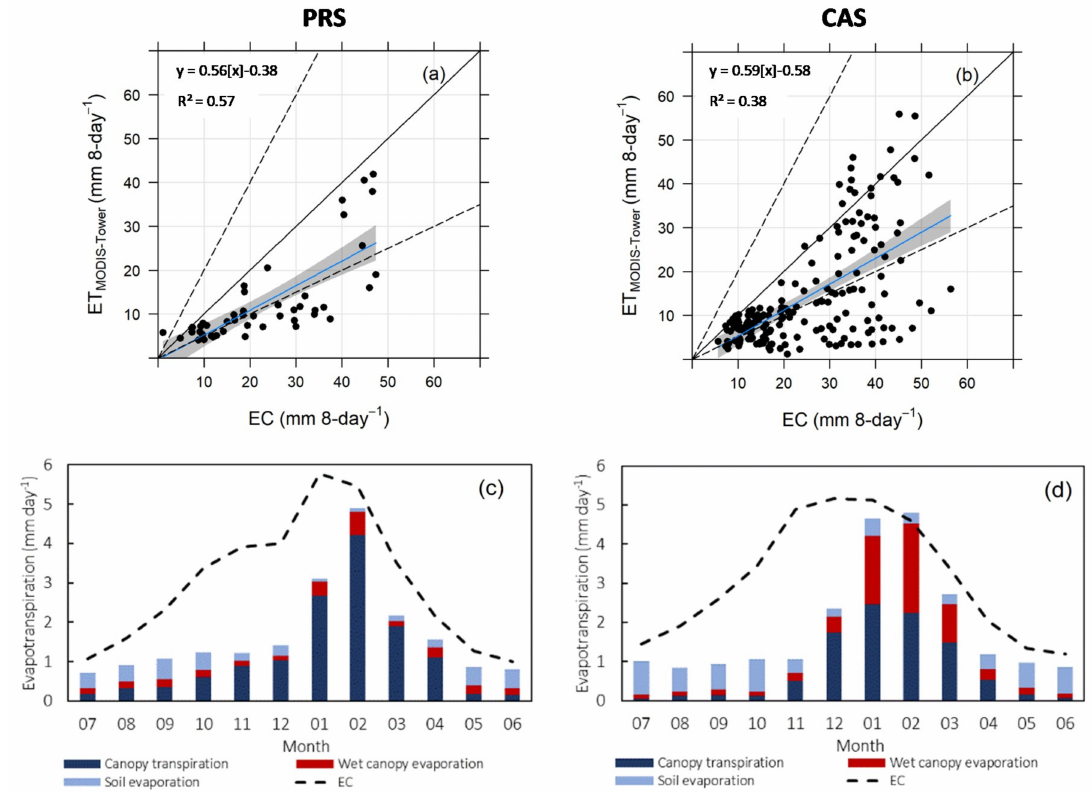
Figure 7. Scatterplots of the 8-day EC measurements against tower-driven MOD16 ET estimates at PRS ( a ) and CAS ( b ). The solid blue lines represent the linear fit of the data and the grey areas represent the 95% confidence intervals. The line equations and R 2 value are also shown. For reference, the 1:1 line is a solid black line and the 1:0.5 and 1:2 lines are dashed. Evapotranspiration partitioning between canopy transpiration, wet canopy evaporation and soil evaporation over flooded cropland (rice cultivated in a flooding system) estimated using tower-driven MOD16 algorithm for 2004–2005 at PRS ( c ) and for 2011–2014 at CAS ( d